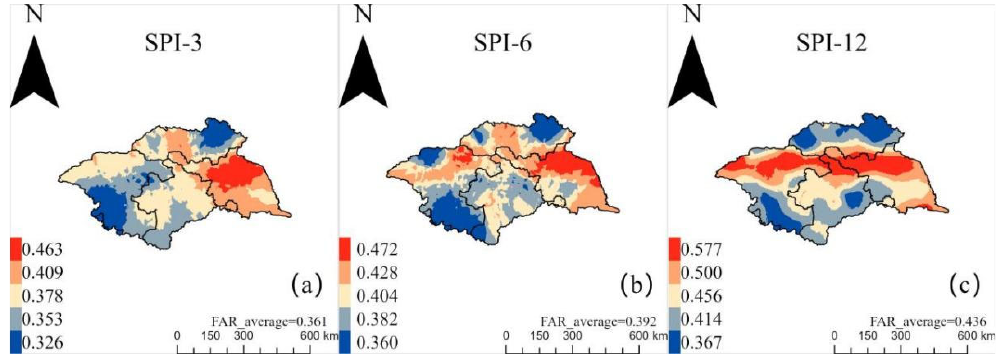
Figure 9. The spatial distribution of FAR for ( a ) SPI ‐ 3, ( b ) SPI ‐ 6, and ( c ) SPI ‐ 12.